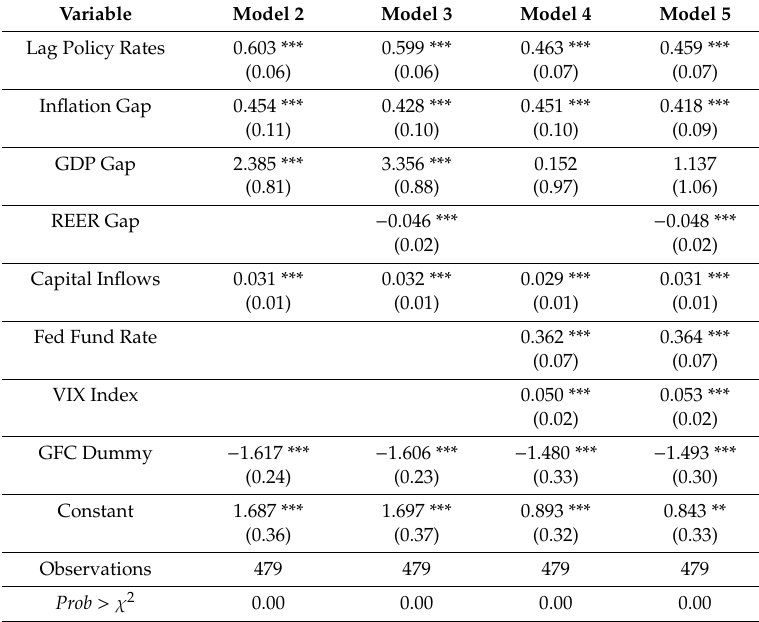
Table 3. The Augmented Taylor Rule with Capital Inflows and GFC